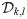
Conformational ensemble of chromosome 10 of human B-lymphoblastoid cells generated from simulations.(A) The contact frequency map from the ensemble of structures generated using MiChroM (upper right corner) generates the overall checkerboard pattern of Hi-C map (lower left corner). The 6 subcompartment types assigned to chromosome loci are depicted on the top. (B) The dendrogram represents the outcome of hierarchical clustering of the ensemble of structures obtained from conformational sampling. Each terminal branch at DRMS = 3.3 a represents the ensemble of structures that can be clustered with the condition of DRMS < 3.3 a. The distance (DRMS) between the two distinct structures k and l is given by Dk,l (Eq 1), and the distance between two clusters K and L is defined as the maximum distance between two conformations, each belonging to the two clusters, i.e., maxk∈K,l∈L{Dk,l}. Among the clusters whose inter-cluster distance is smaller than Dc=4.5a, the centroid structures (kc ∈ K), which minimize ∑kc,k∈KDkc,k, are depicted in rainbow coloring scheme. As suggested by the contact map of each chromosome structure shown at the bottom, the centroid structure of each cluster is distinct from each other. We have selected these five structures as the initial conformations for generating trajectories for dynamic simulations of chromosomes.